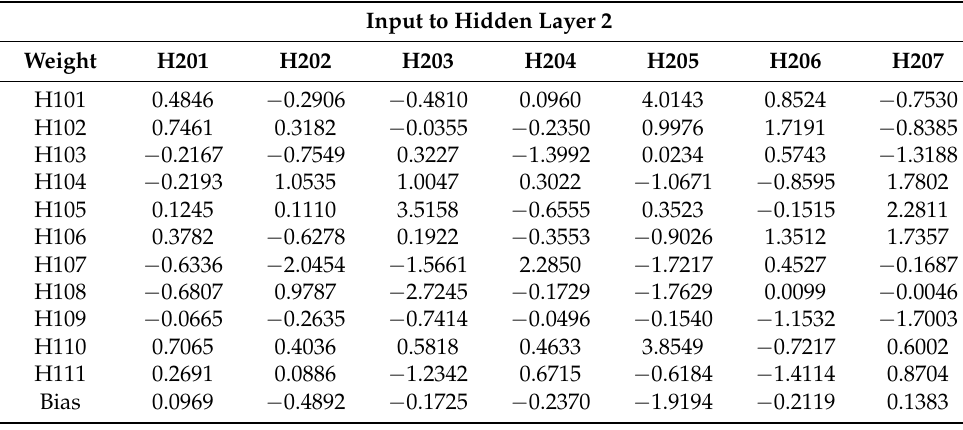
Table 27. Weight and bias between the first and second hidden layers (CAE-1024).